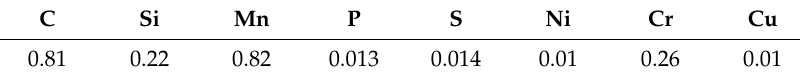
Table 1. Chemical composition of the SWRS82B steel